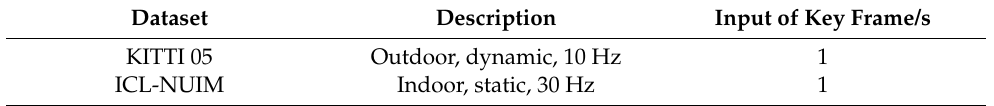
Table 6. Description of datasets.